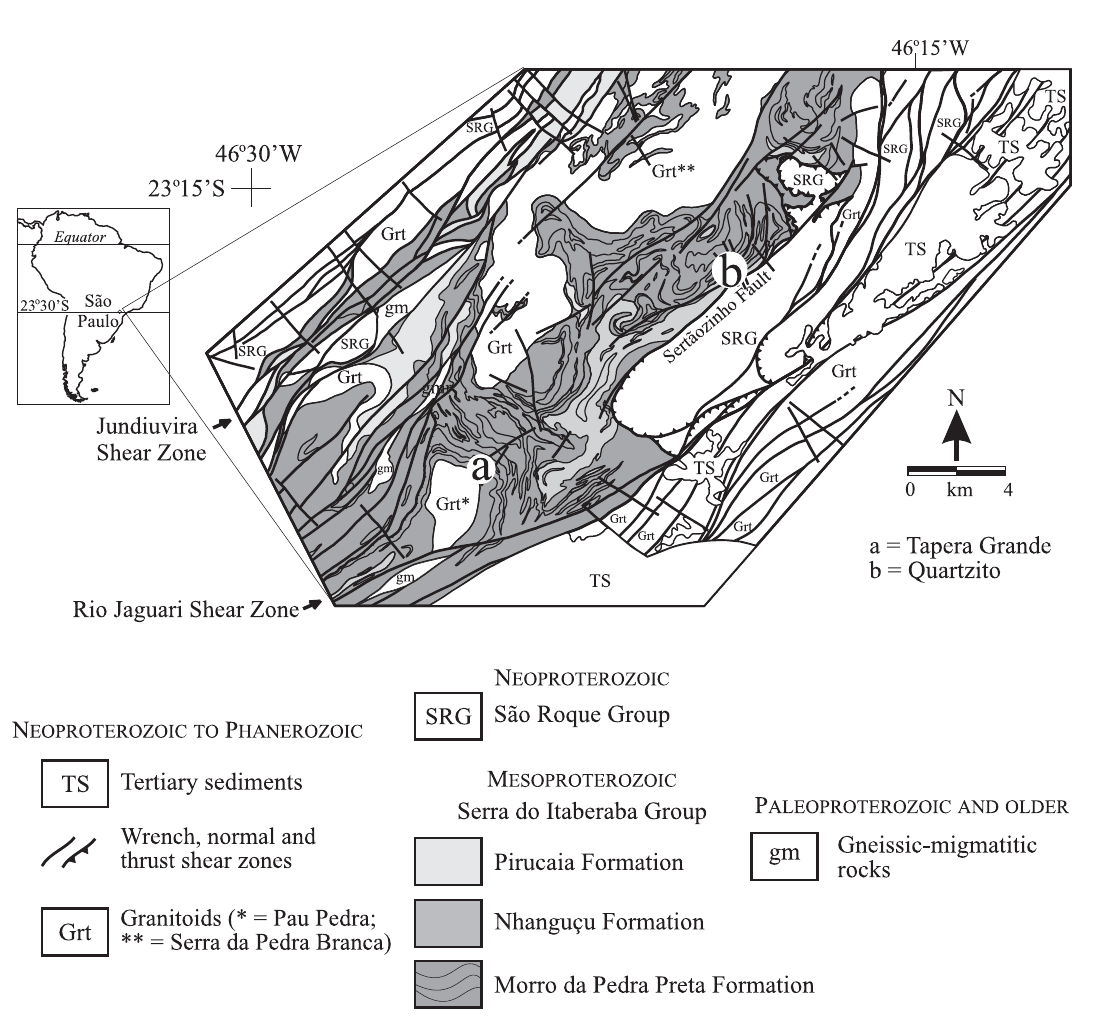
Fig. 1 – Simplified map of Serra do Itaberaba and São Roque Groups (modified from Juliani